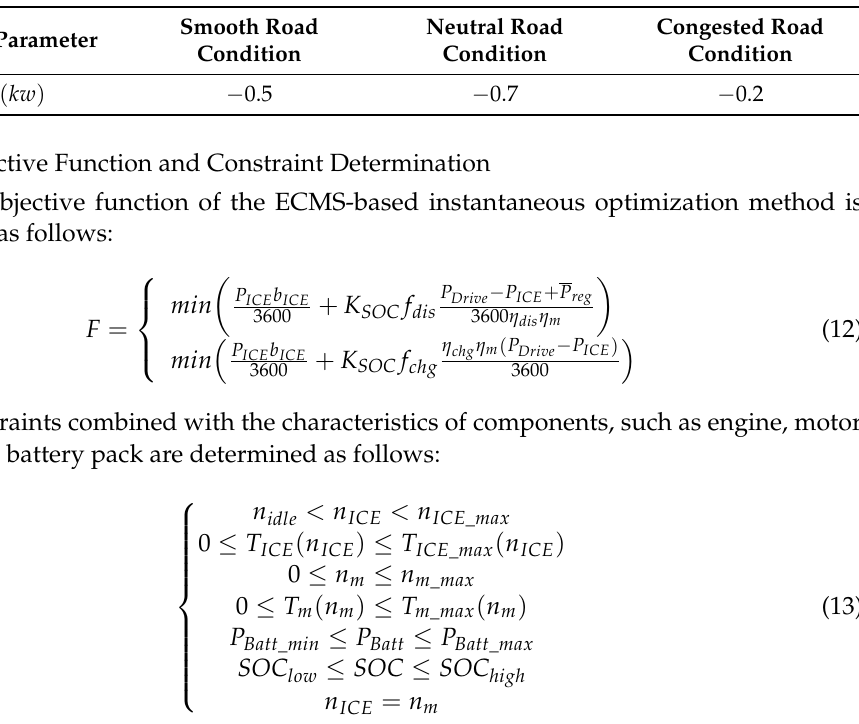
Table 2. Average regenerative braking power value under different road conditions.